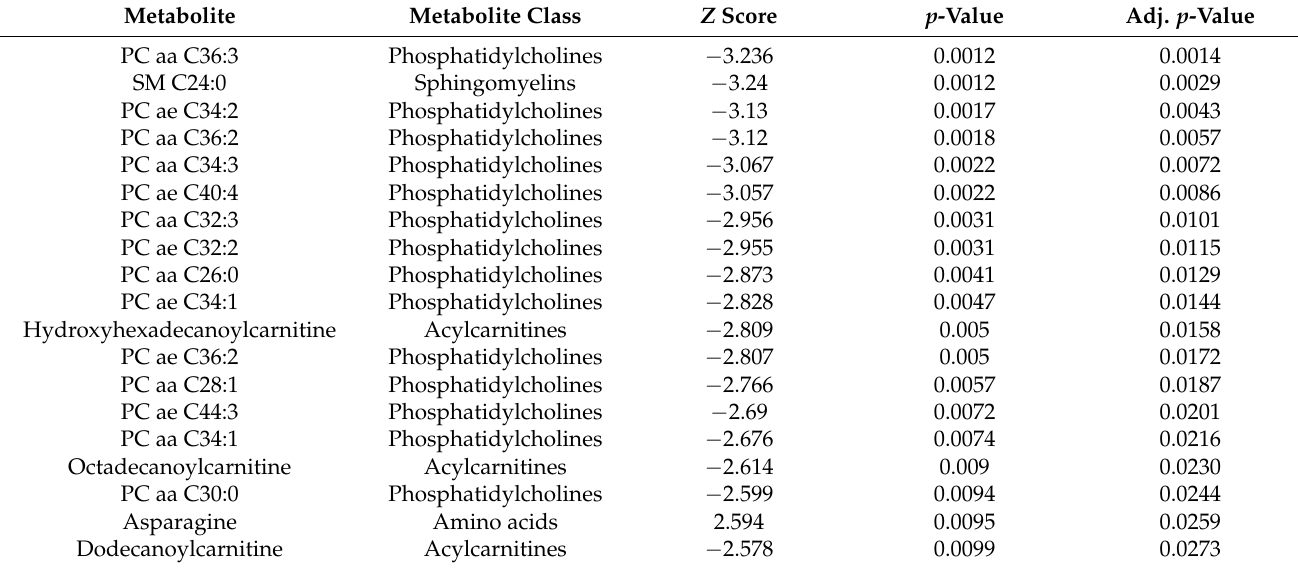
Table 1. List of metabolites in the blood associated with HMGCR rs12916-T allele.